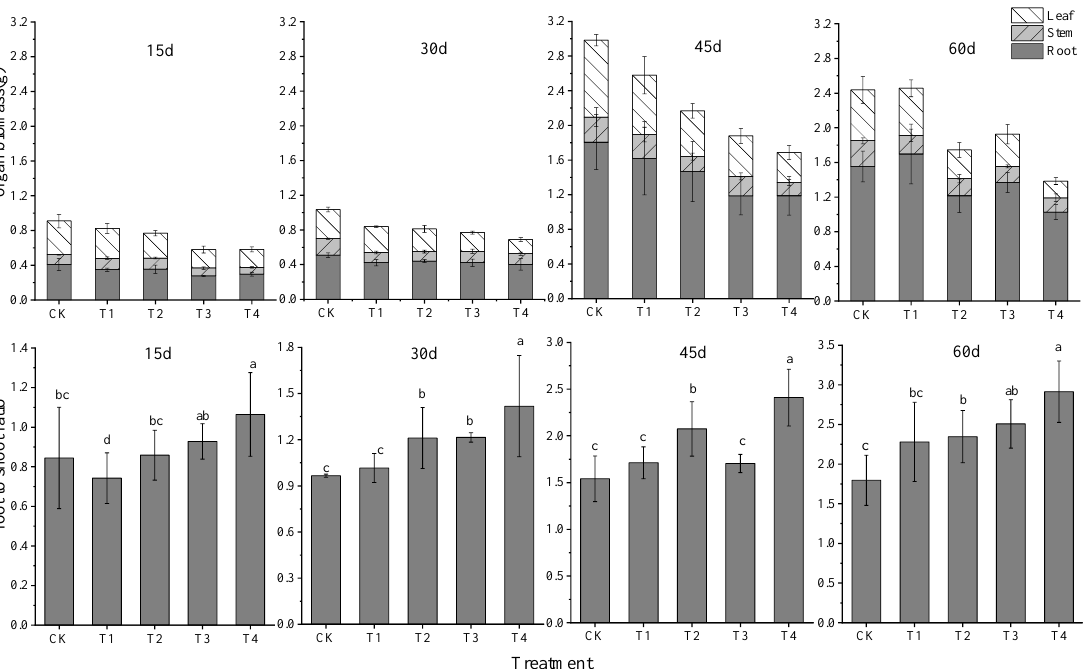
Figure 1. The biomass distribution in organs of Glycyrrhiza uralensis under different water stress treatments. Different lowercase letters indicate significant differences among treatments at 5% level.